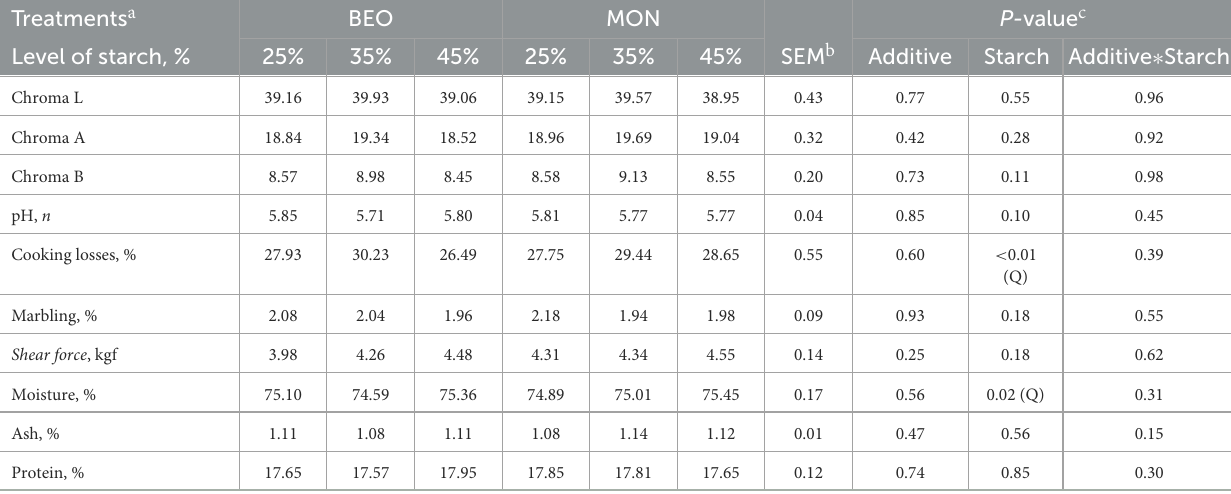
TABLE 4 Levels of starch associated with blend of essential oils or sodium monensin on shear force analysis and meat color of Nellore yearling bulls. Treatments a BEO MON P- value c Level of starch, % 25% 35% 45% 25% 35% 45% SEM b Additive Starch Additive ∗ Starch Chroma L